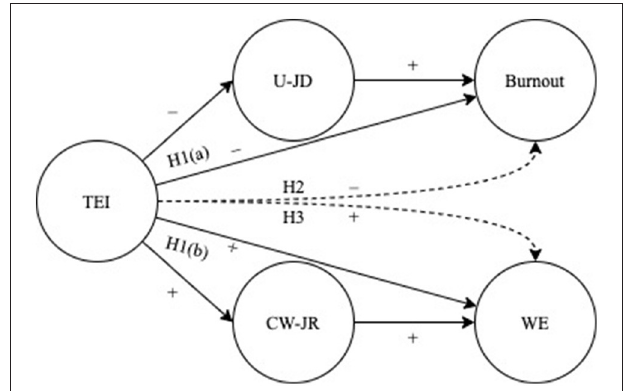
FIGURE 1 | Graphical summary of study’s conceptual model and hypotheses. ( + ) and ( − ) signs indicate the positive and negative hypothesized associations, respectively. H1(a) = hypothesis 1(a); H1(b) = hypothesis 1(b); H2 = hypothesis 2; H3 = hypothesis 3. TEI, trait emotional intelligence; U-JD, end-user job demands; CW-JR, coworkers related job resources; WE, work engagement. Continuous lines = direct relationship; discontinuous lines = indirect